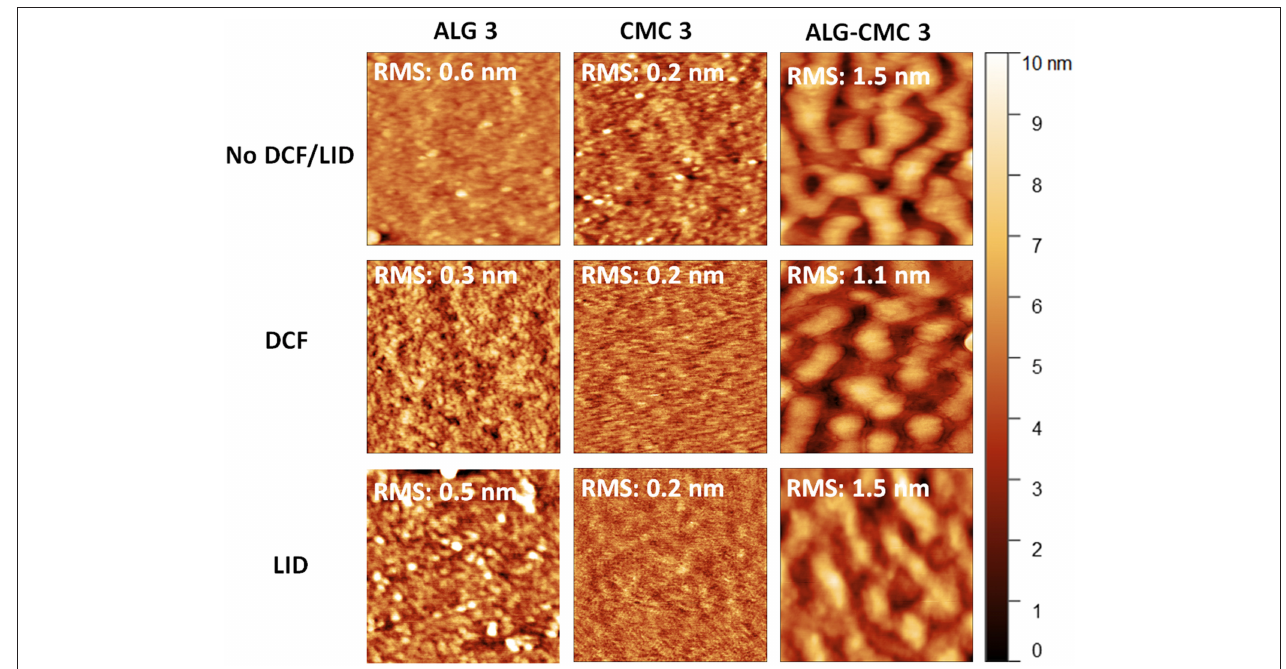
FIGURE 1 | AFM height images (size: 1 × 1 µ m 2 ) of polysaccharide nanofilms, without drugs (top) , with DCF (middle) , and with LID (bottom)